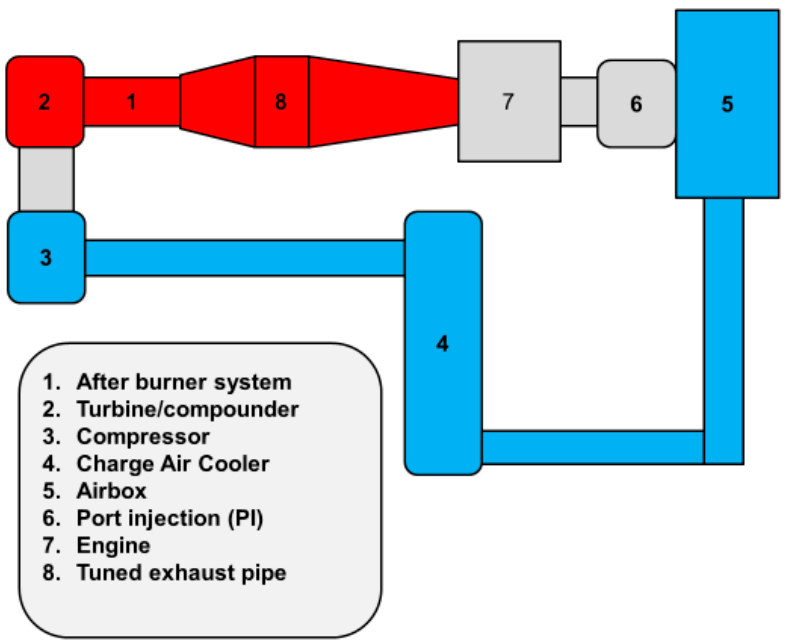
Figure 2. The BUREX engine is a single-cylinder two stroke engine with an afterburner-assisted turbocharged system that increases power density and reduces exhaust emissions. The target power of 150 kW can be achieved using a cylinder with a swept volume of 425 cc.